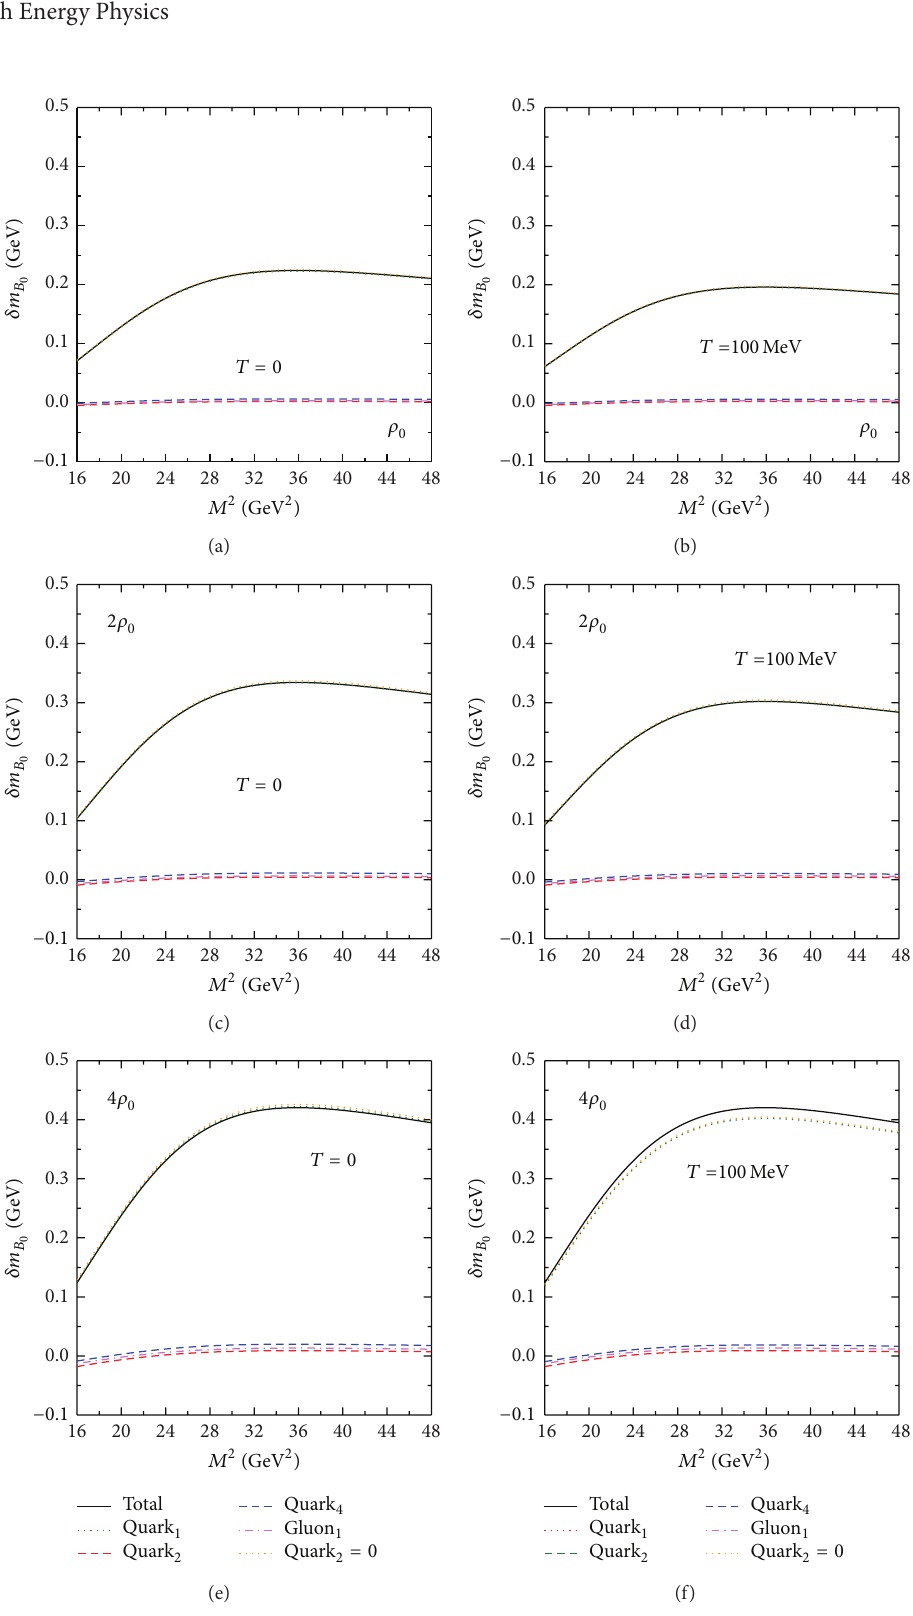
Figure 9: (Color online) Figure shows the contribution of individual condensates to the mass shift of scalar vector mesons 𝐵 0 as a function of the squared Borel mass parameter, 𝑀 2 . The subplots (a), (c), and (e) show the results at temperature 𝑇 = 0, whereas the subplots (b), (d), and (f) are plotted for temperature 𝑇 = 100 MeV. We have shown the results at baryon densities 𝜌 0 , 2𝜌 0 , and 4𝜌 0